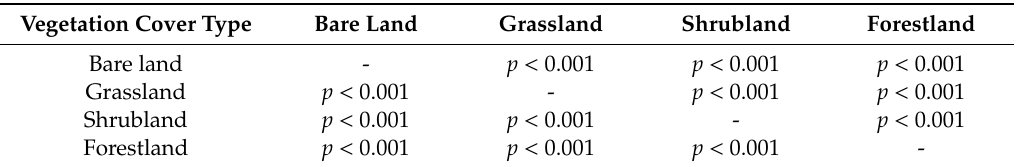
Figure 2. Mean levels and temporal variations in volumetric soil moisture content with respect to different vegetation cover types. Error bars refer to the temporal standard deviations of soil moisture content ( a ) and the standard deviations of three repetitions ( b ), which reflect the temporal variations in soil moisture content and the errors of three repetitions respectively. Table 2. Comparison of soil moisture content data under different vegetation cover types based on the Mann–Whitney’s U test with Bonferroni correction ( p -value).